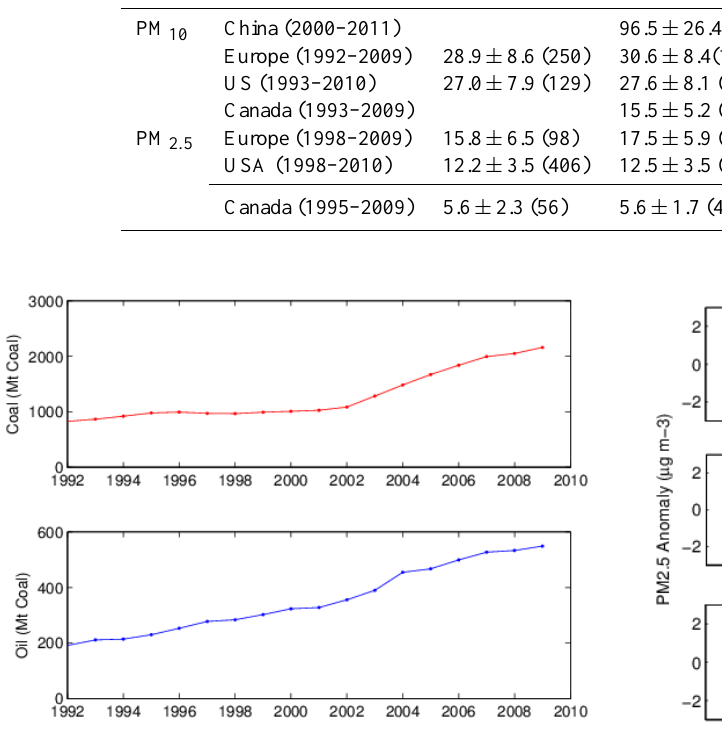
Fig. 5. Total coal and oil consumption in China from 1992 to 2009 (unit: million ton coal, data source: National Bureau of Statistics of China, available at http://www.stats.gov.cn/tjsj/ndsj/, in Chinese).